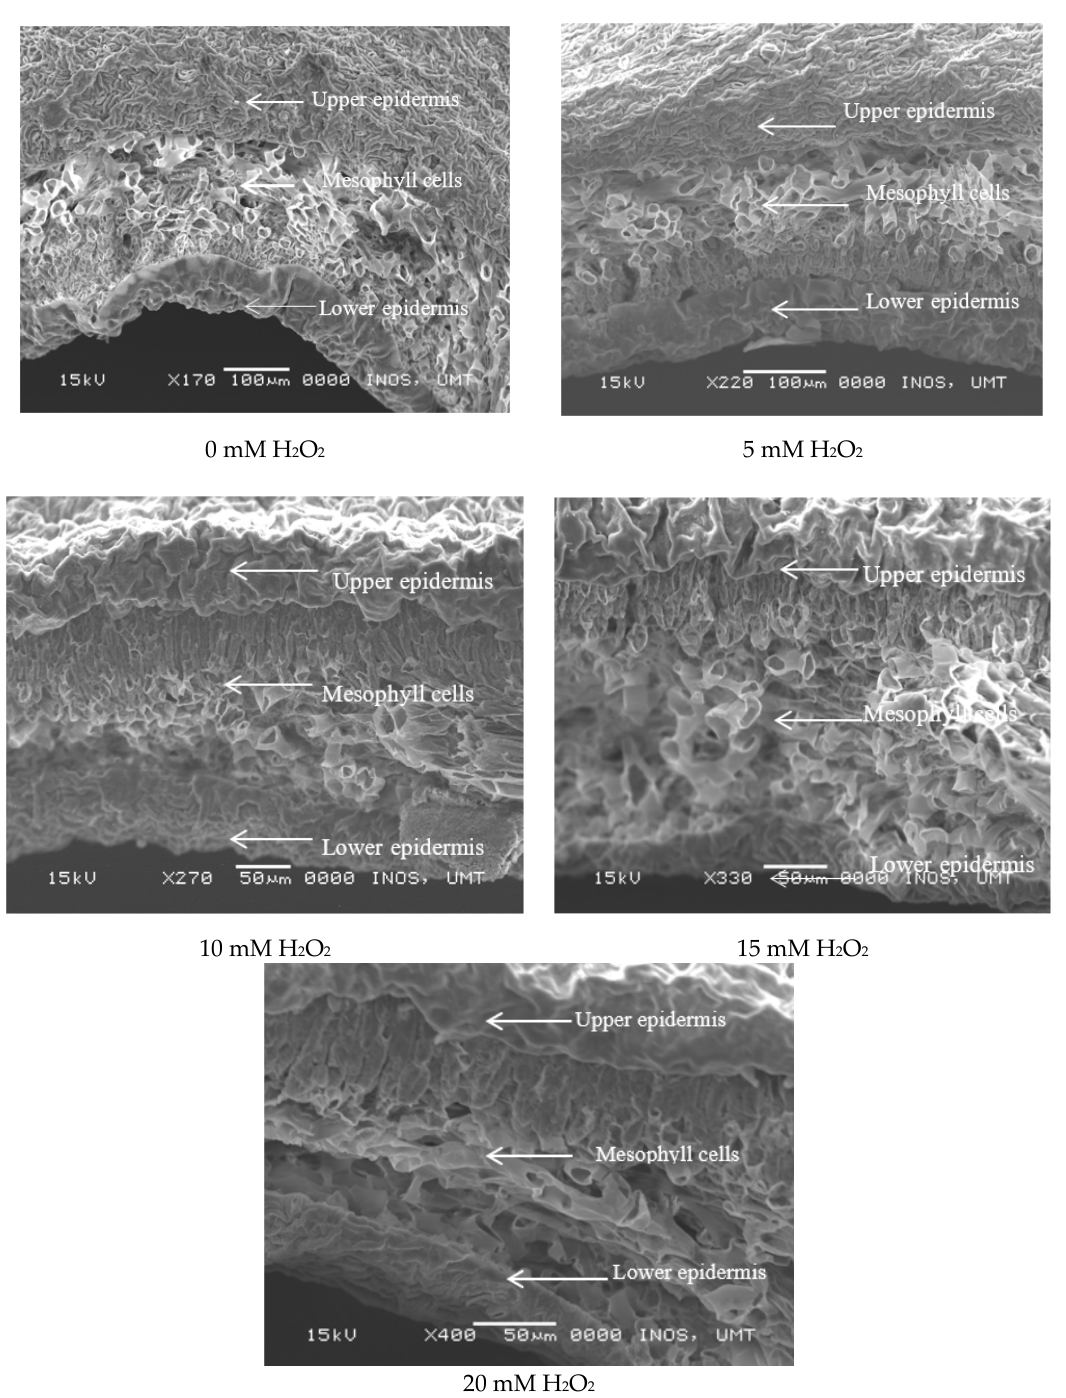
Figure 5. SEM photographs (cross section) showing the spongy mesophyll cells, upper and lower epidermis of the treated and untreated leaves of Ficus deltoidea var. deltoidea plant.